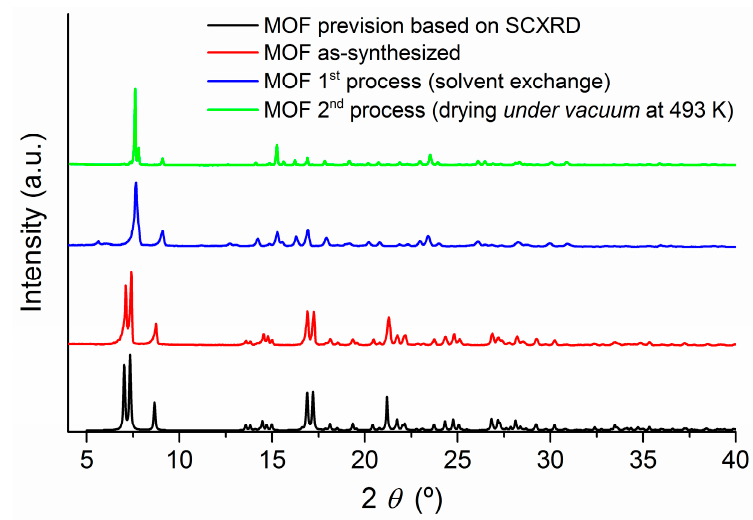
Figure 2. Powder X-ray diffraction patterns of the simulated pattern based on the single crystal structure of [Zn 2 (bpdc) 2 (bpee)] ( black ), the as-synthesized metal-organic framework (MOF) ( red ), a MOF sample after the first process—solvent exchange ( blue )—and a MOF sample obtained after the second process—drying under vacuum at 493 K for 5 h ( green ).